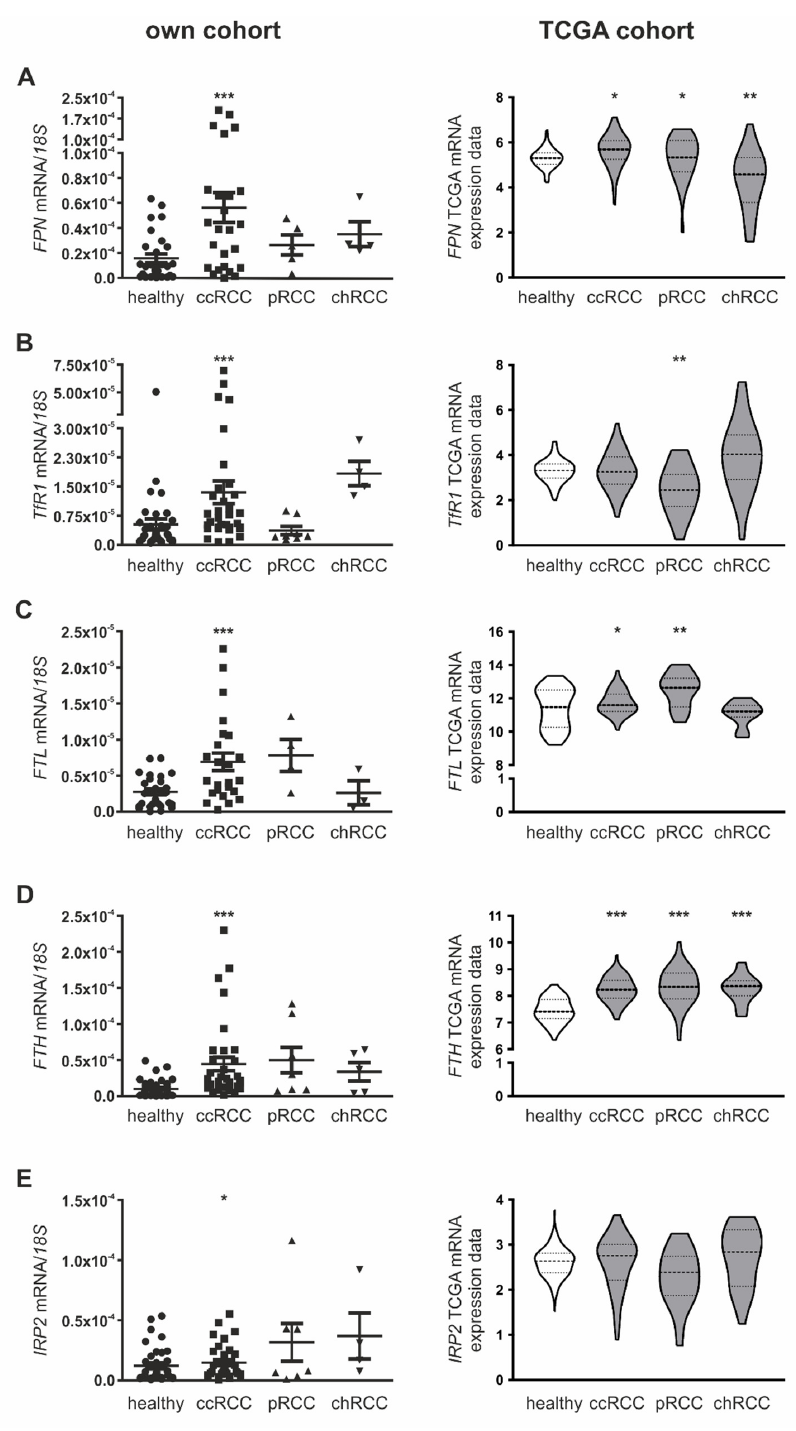
Figure 2. Profile of iron-regulated genes in histopathologically distinct RCC subtypes. mRNA expression of renal tumor and adjacent healthy samples in clear cell (ccRCC), papillary (pRCC), and chromophobe (chRCC) RCC of own patient cohort (left) compared to mRNA expression acquired from the TCGA database applying the ccRCC-KIRC ( n = 70), pRCC-KIRP ( n = 31), and chRCC-KICH ( n = 23) datasets (right). Analyzed genes include ( A ) FPN , ( B ) TfR1 , ( C ) FTL , ( D ) FTH, and ( E ) IRP2 . Own cohort is normalized to housekeeping gene 18S expression. Graphs are displayed as means ± SEM with * p < 0.05, ** p < 0.01, *** p < 0.001.